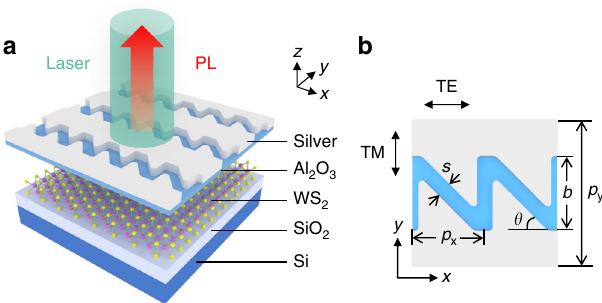
Fig. 1 Schematics of the WS 2 -Ag hybrid nanostructure. a 3D schematic view of the hybrid plasmonic device consisting of silver sawtooth nanoslit array on top of WS 2 monolayer separated by a thin layer of Al 2 O 3 . The device is pumped by a 532 nm laser with the incident polarization fi xed in the x direction. b Top view of two unit cells for the sawtooth nanoslit array with geometrical parameters: p x = 200 nm, p y = 400 nm, s = 40 nm, b and θ are two